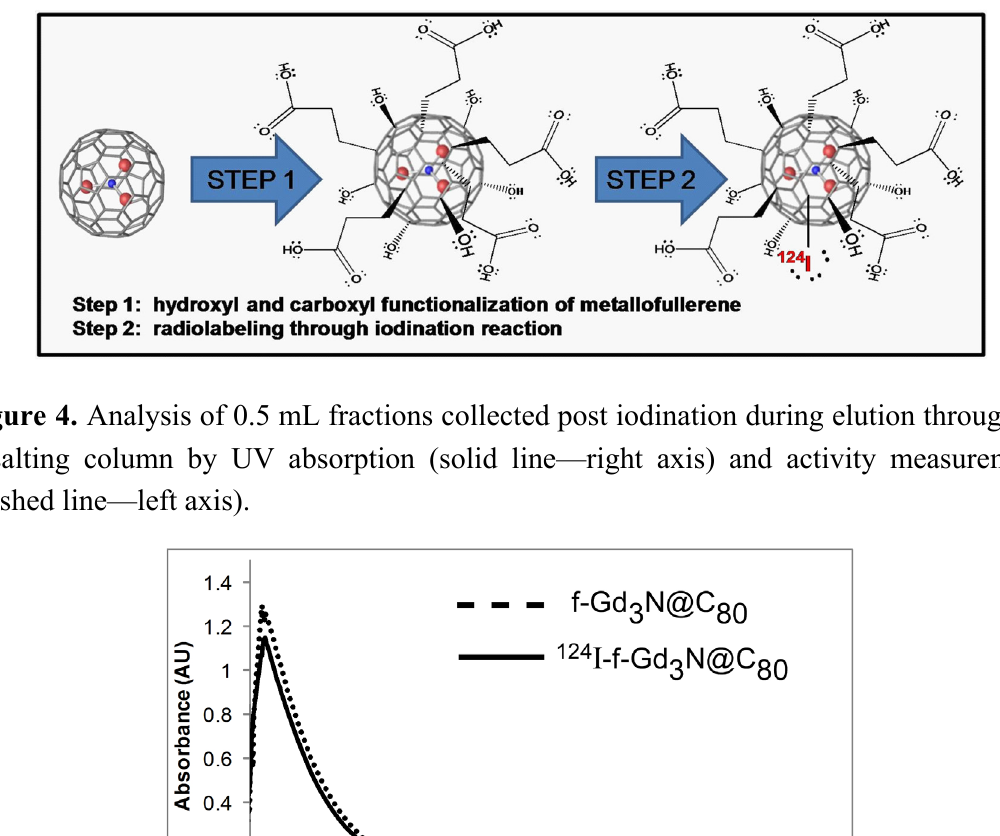
Figure 3. Illustration of the reaction scheme starting with the endohedral metallofullerene and resulting in the aqueous soluble, iodinated, dual-modality imaging probe.